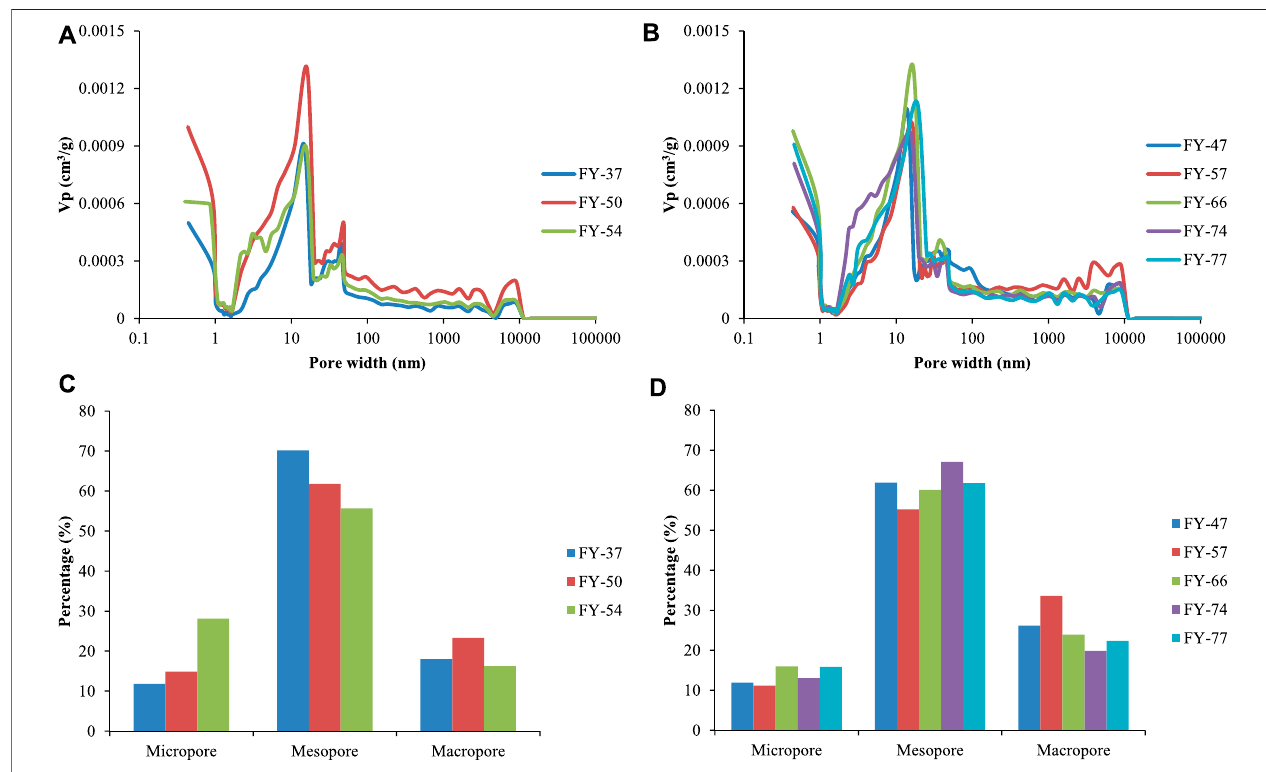
FIGURE7| Poresizedistributioncharacteristicsofdifferentlithofaciesshale. (A) poresizedistributionofmixedshale; (B) poresizedistributionofargillaceousshale; (C) proportion characteristics of pores in different scales of mixed shale; (D) proportion characteristics of pores in different scales of argillaceous shale.